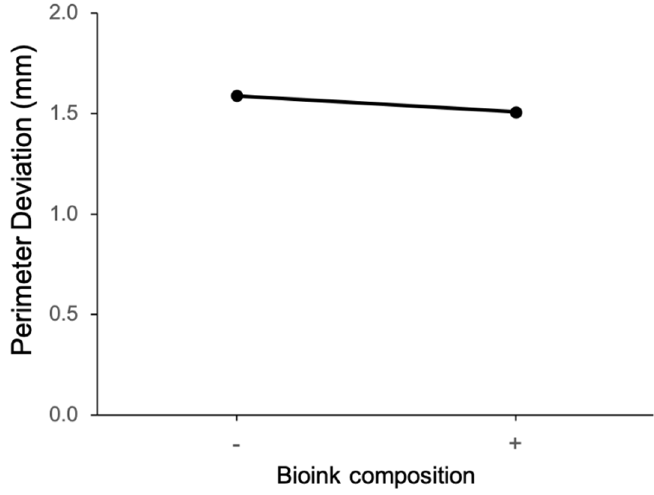
Figure 8. Main effect of bioink composition on perimeter deviation.